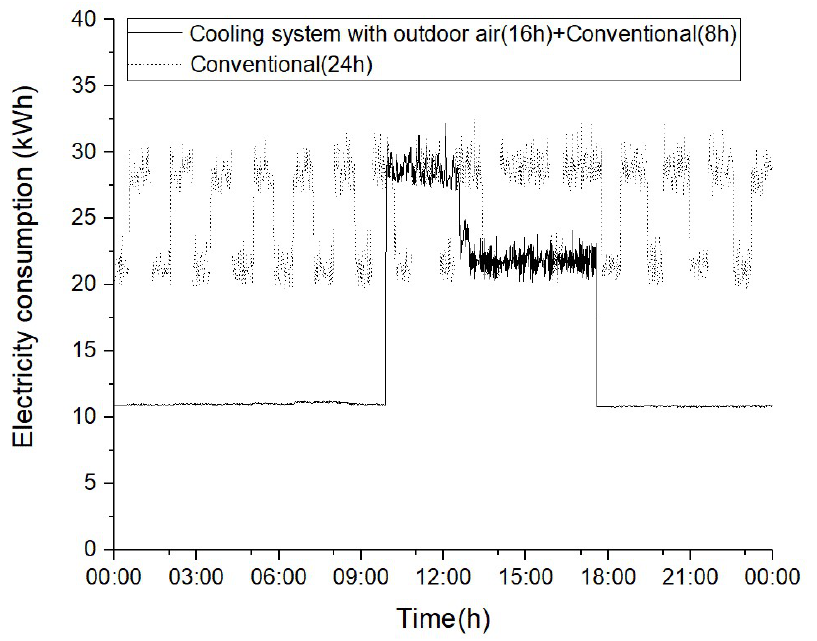
Figure 6. Comparison of the daily electric power consumption of the conventional and the proposed cooling method.